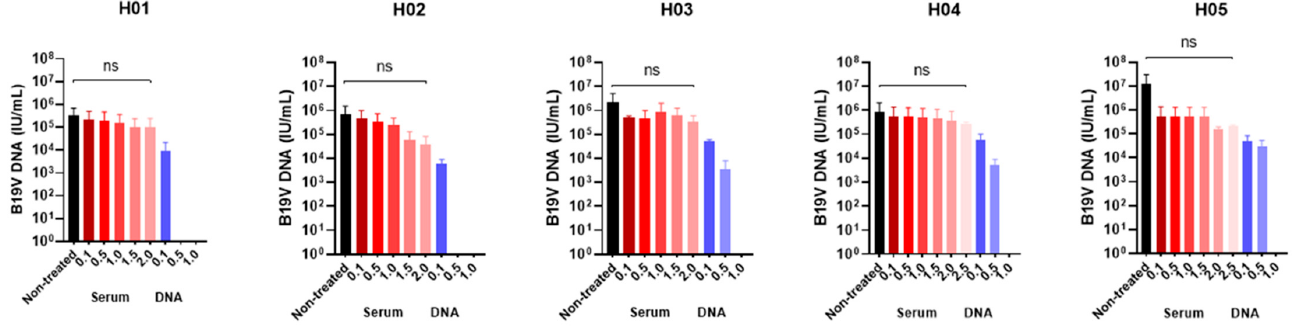
Figure 2. Optimization of Benzonase ® concentration among human serum samples. IU/mL: International Units per milliliter. Ns: non-significative.